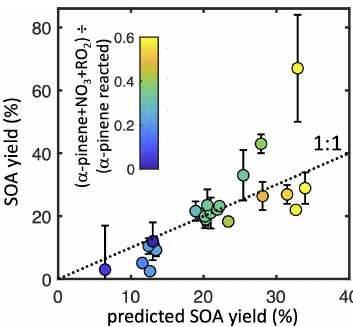
Figure 5. Measured (non-ozonolysis-corrected) SOA mass yields from each experiment as a function of the modeled contribution of n RO 2 + n RO 2 (color) and of the predicted SOA yield from the sum of each pathway contribution ( x axis). Error bars denote uncertainty from SMPS